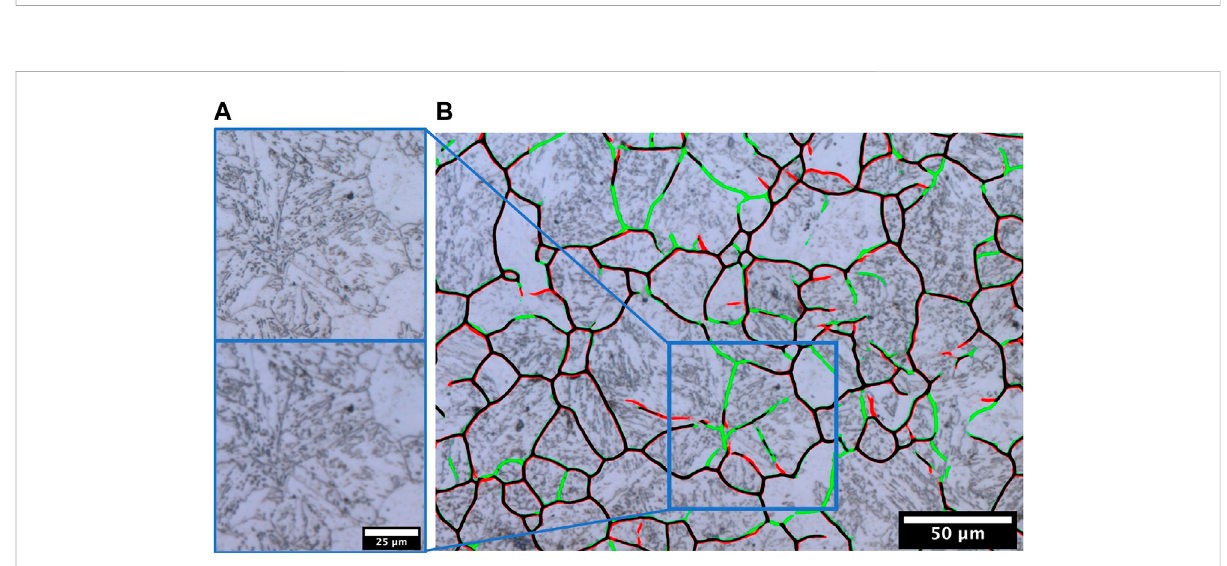
FIGURE 11 Testing model on blurred micrograph (A) (mean fi lter — three px: left upper shows sharp micrograph-left lower shows blurred micrograph). Overlay of the segmentation results, without any post-processing [ (B) — green: original image, red: blurred image, black: overlap between the